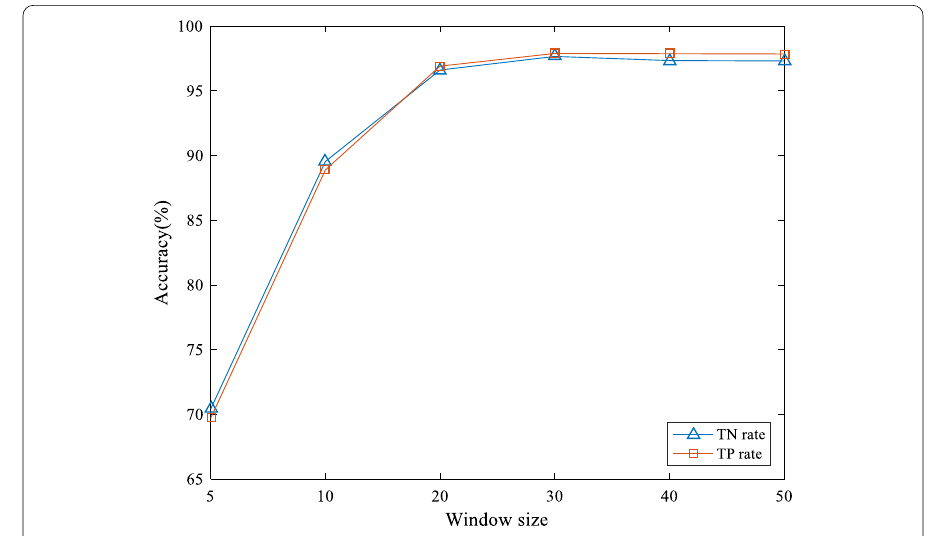
Fig. 13 Detection TN rate and TP rate with different window